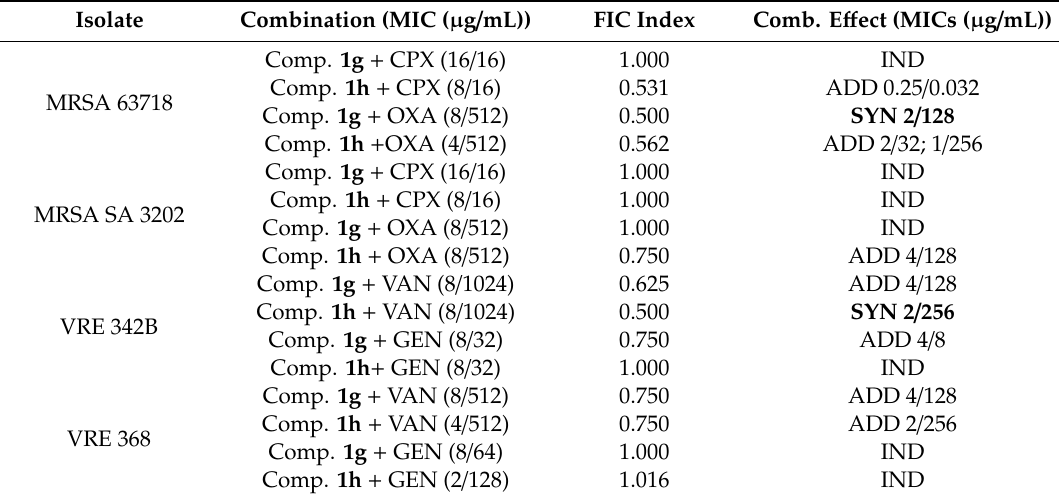
Table 3. E ff ect of tested compounds in combination with clinically used antibiotics. The MICs ( µ g / mL) of each antibacterial drug alone and observed in the synergy experiment are shown in parentheses. In the case of additivity and synergy, the concentrations of the tested compound / clinically used antibiotic ( µ g / mL) providing this e ff ect are shown. Isolate Combination (MIC ( µ g / mL)) FIC Index Comb. E ff ect (MICs ( µ g /